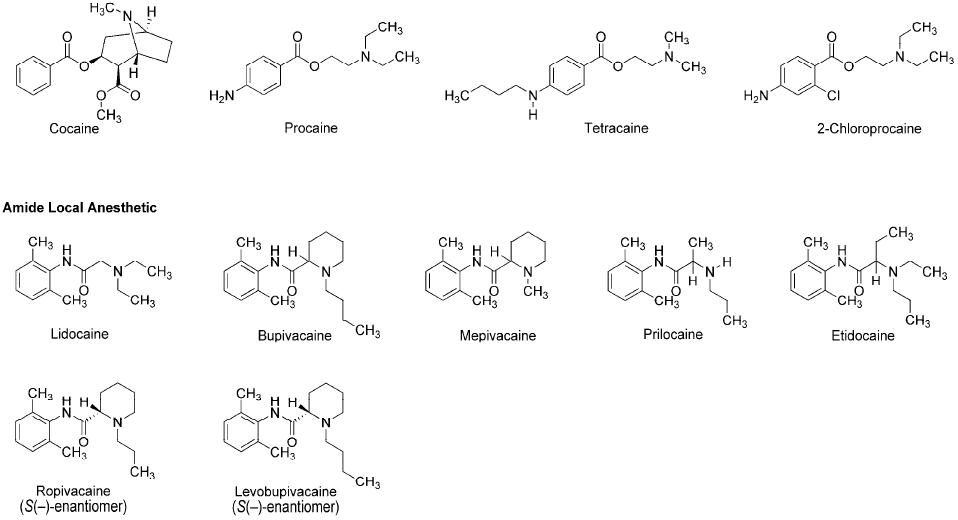
Figure 1. Local anesthetics derived from the plant alkaloid cocaine.